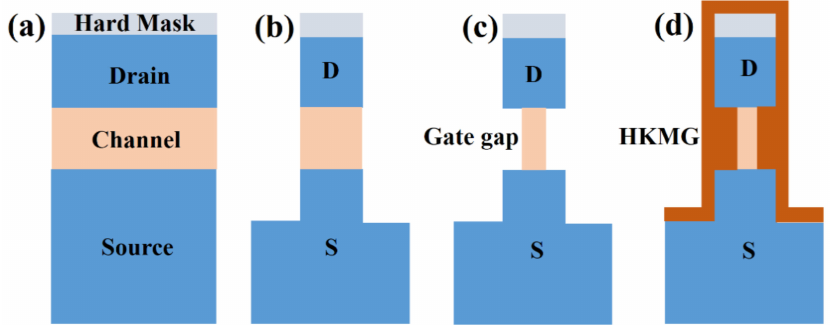
Figure 1. Schematic diagram of the basic flow of vertical Gate-all-around FET (vGAAFETs). ( a ) Sand- wich structure and hard mask growth, ( b ) lithographic patterning and plasma anisotropic etching, ( c ) channel isotropic selective etching to form laterally depressed channels and gate gaps, ( d ) gate gaps filling with high-k metal gate